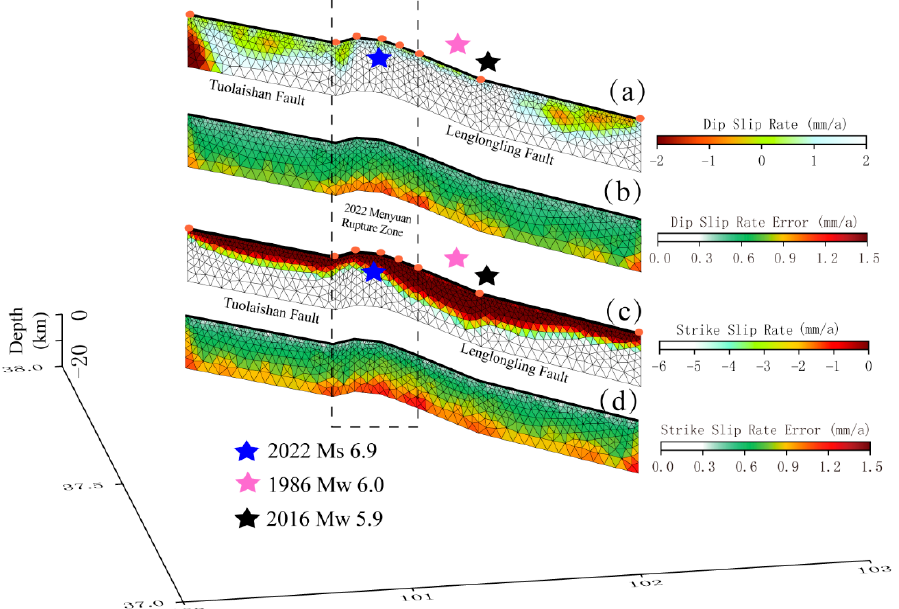
Figure 8. Distribution of the fault slip rates during interseismic periods. ( a ) Dip-slip rates, in which the red (negative) values represent downward motion. White (positive) values indicate upward motion. ( b ) Error distribution of the dip-slip component of the fault. ( c ) Strike-slip rates, in which negative values indicate left-lateral strike-slip motion to the east. ( d ) Error distribution of the strike-slip rate, in which stars represent the three seismic events near the Lenglongling Fault and the dotted rectangle indicates the rupture area of the 2022 Menyuan earthquake.